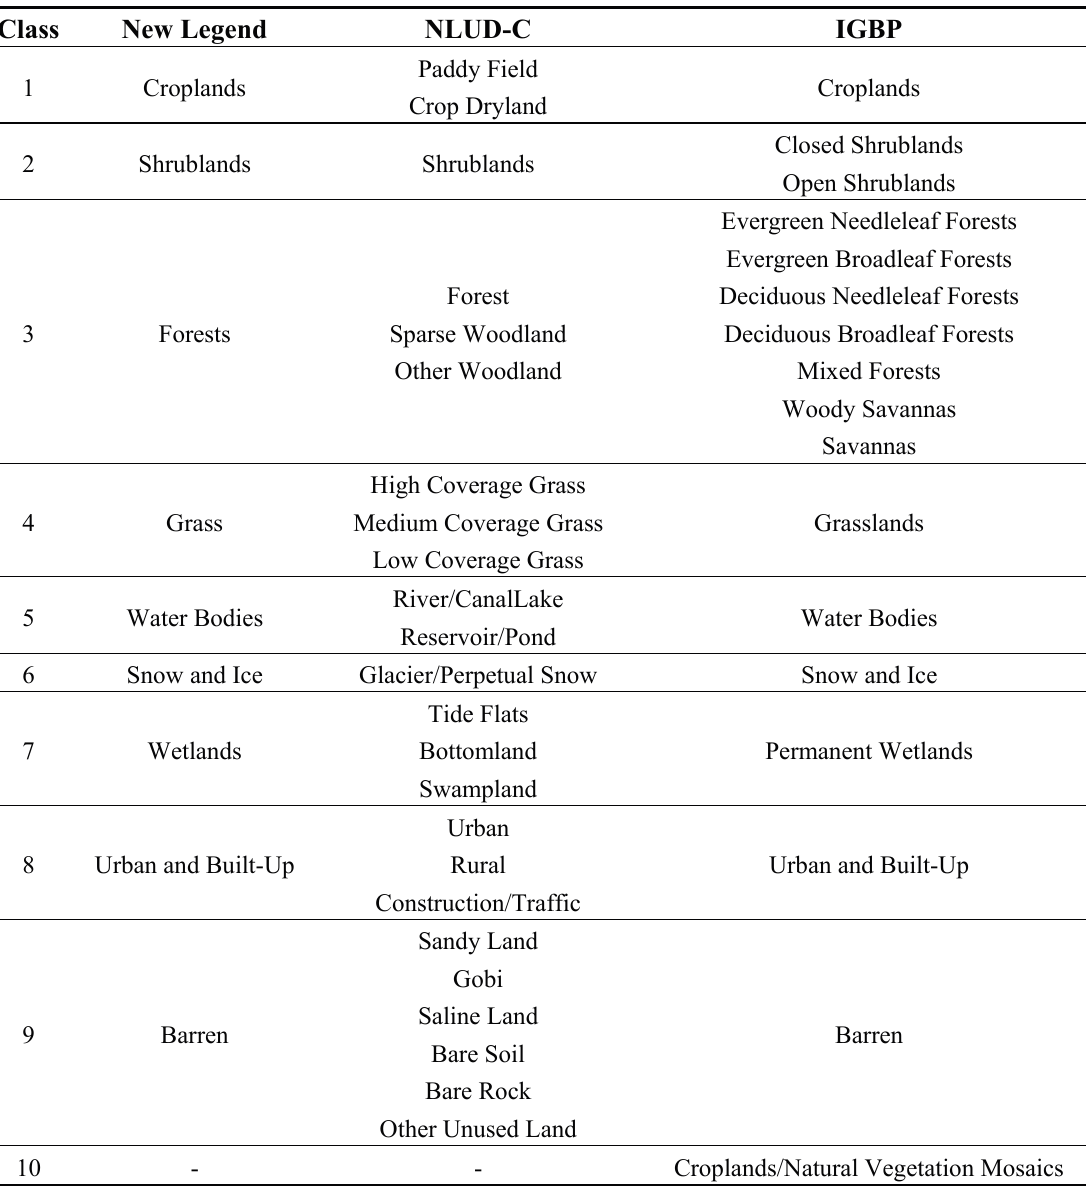
Table 2. Generalized land cover legend. NLUD-C, national land use/cover database of China; IGBP, International Geosphere-Biosphere